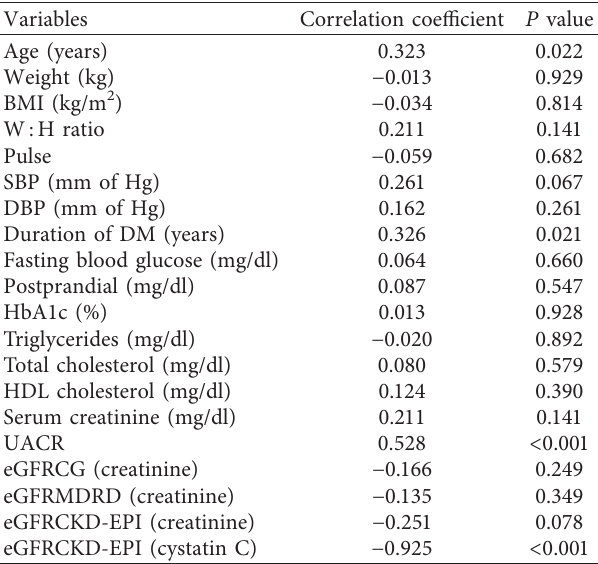
Table 3: Correlation of serum cystatin C with other parameters in T2DM